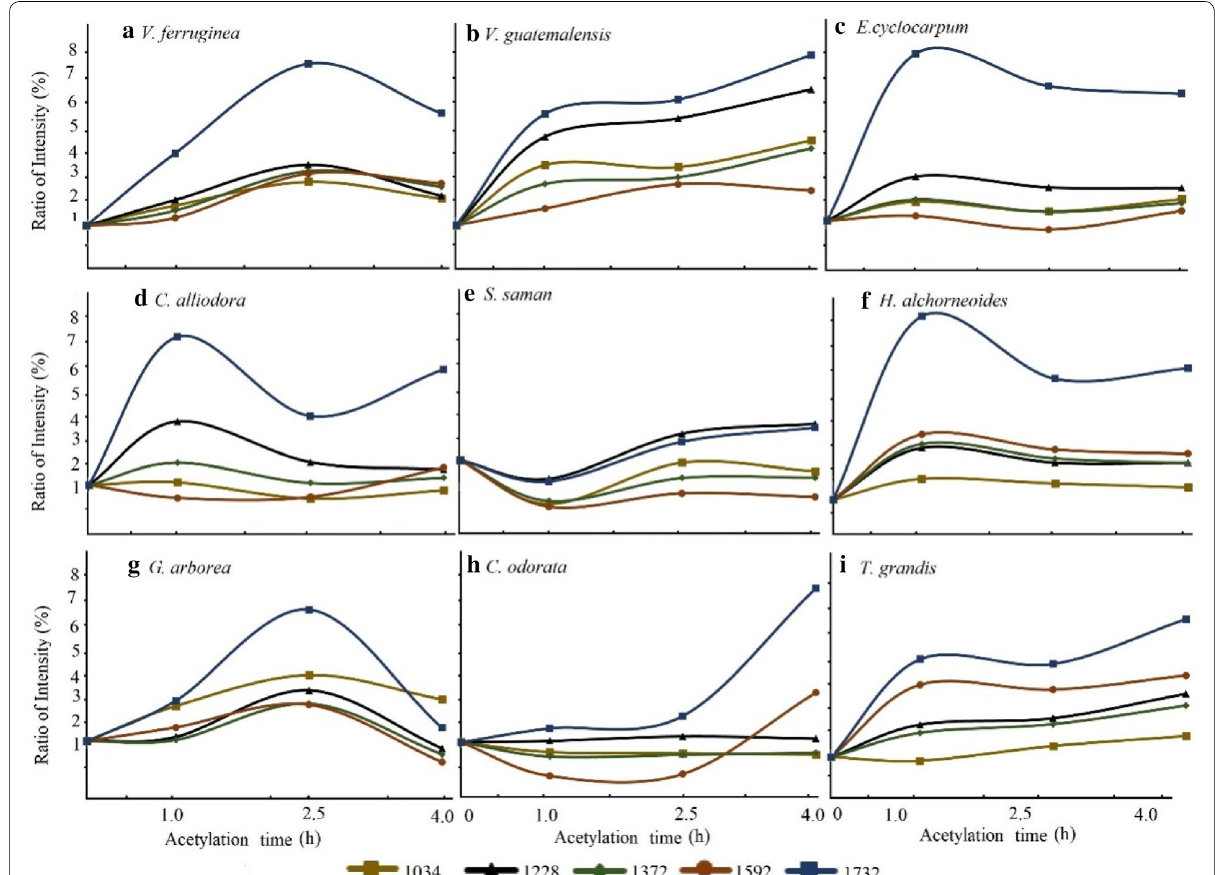
Fig. 2 Ratio of intensity of the absorbance in FTIR spectra of acetylated tropical hardwoods modified in different acetylation